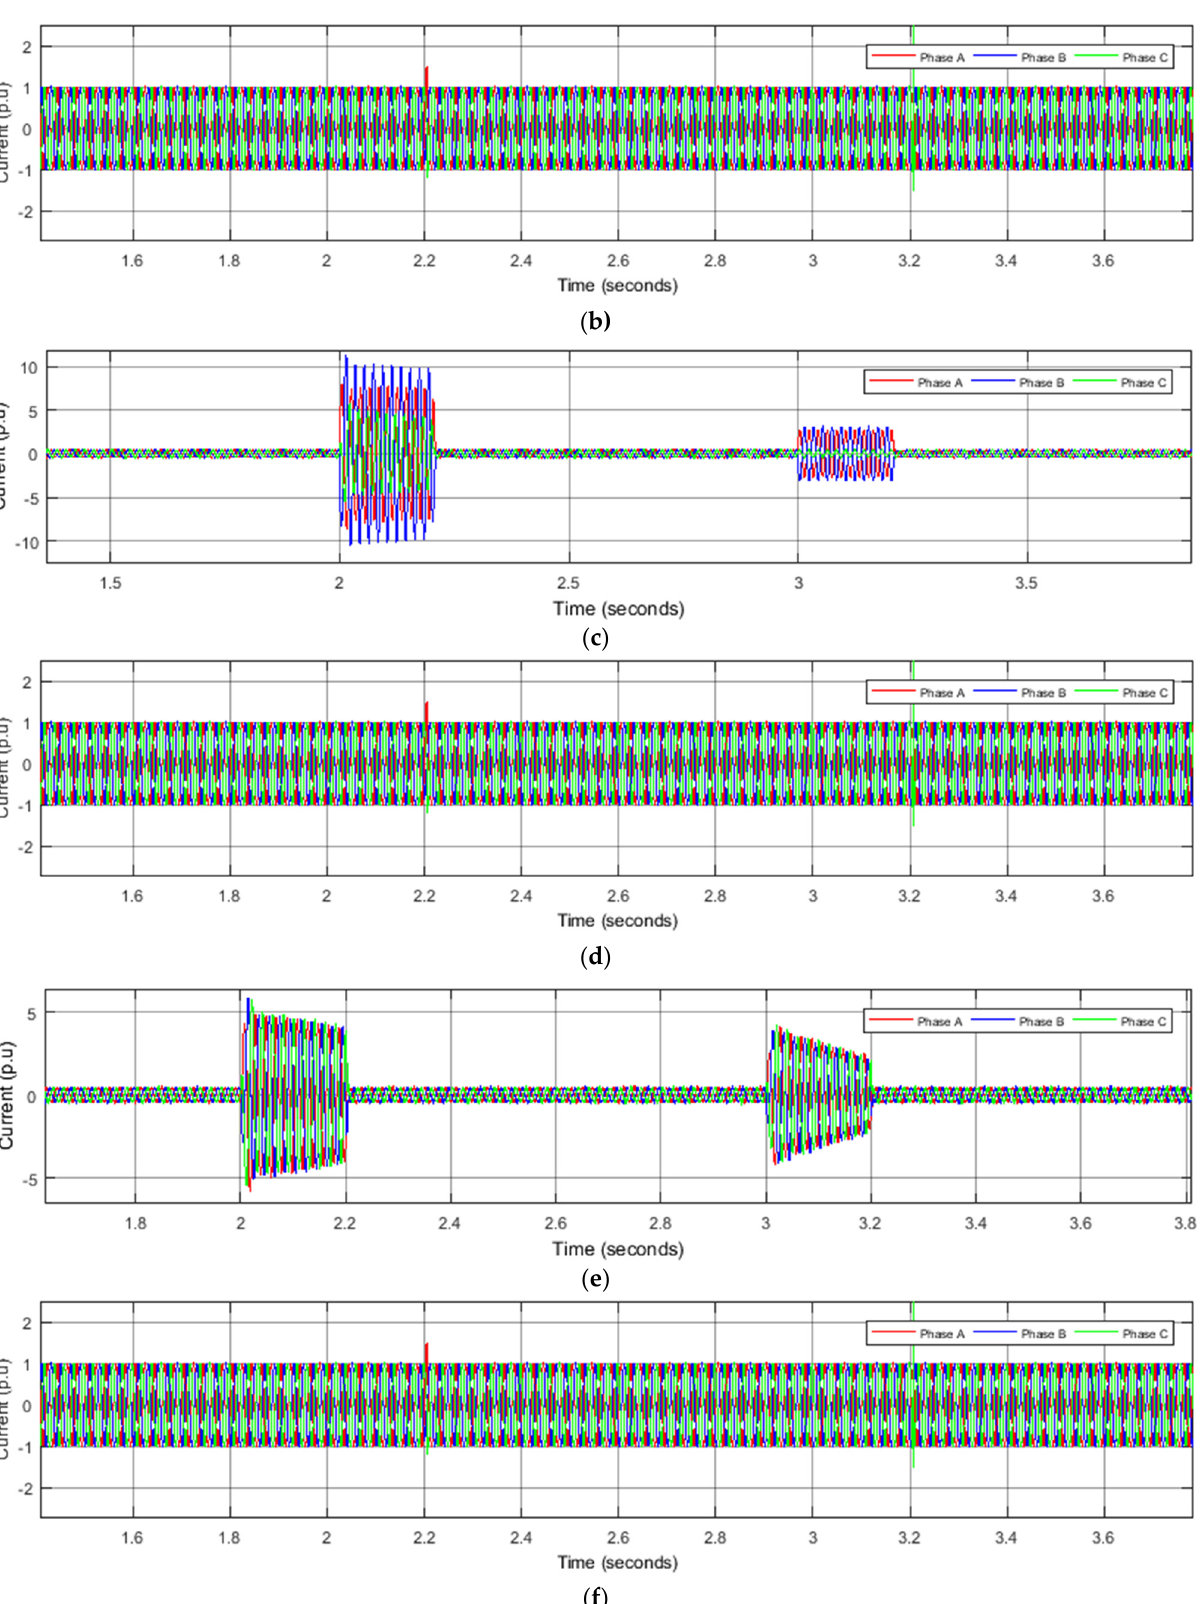
Figure 22. Stator current: ( a ) three phase without compensation; ( b ) three phase with DVR and V2G compensation; ( c ) double phase without compensation; ( d ) double phase with DVR and V2G compensation; ( e ) single phase without compensation; ( f ) single phase with DVR and V2G compensation.